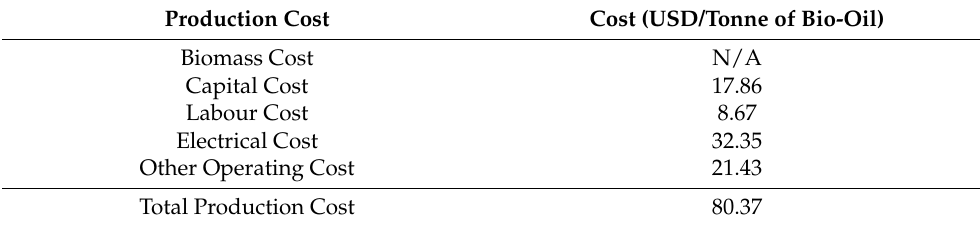
Table 4. Summarised pyrolysis bio-oil production cost.